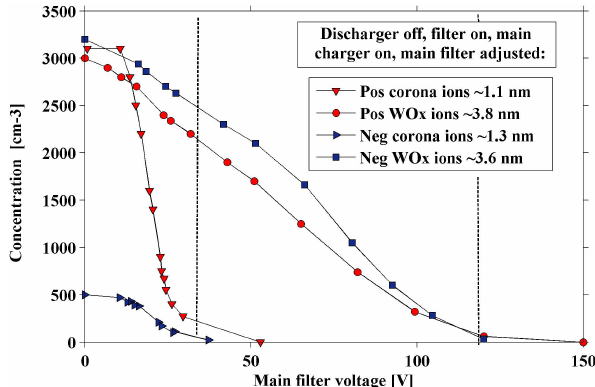
Fig. 9. Filtering of the charged particles with the main electrical fil- ter. The concentration of corona ions and sample particles decreases as a function of the voltage applied to the filter electrode, with most of the charger ions being removed around 30V. The corona voltage was ± 3kV and pre-filter ±